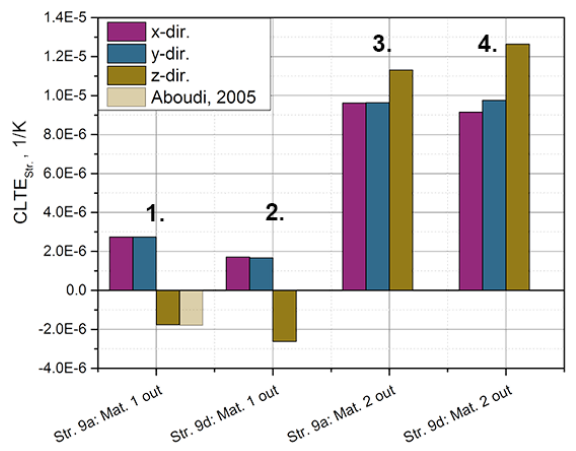
Figure 5. Von Mises stresses of a two-phase system caused by temperature increase.